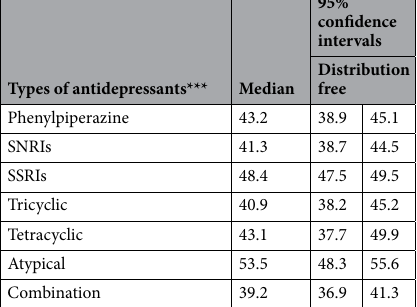
Table 4. Physical health-related quality of life associated with antidepressant agents. SSRIs: Selective serotonin reuptake inhibitors; SNRIs: Serotonin and norepinephrine reuptake inhibitors; Combination: Patients using multiple antidepressants. ***Statistically significant at p <